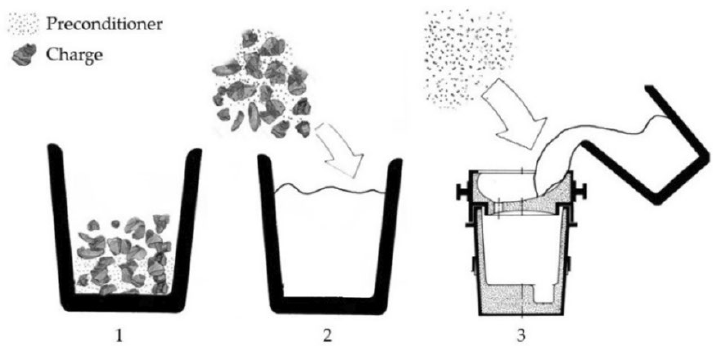
Figure 1. Illustration of the different preconditioning treatments: ( 1 ) preconditioning at charge (CP Un ), ( 2 ) preconditioning at last cold charge (LCP Un ) ( 3 ) preconditioning at tapping (TP Un ). Table 2. Summarized sample identification.